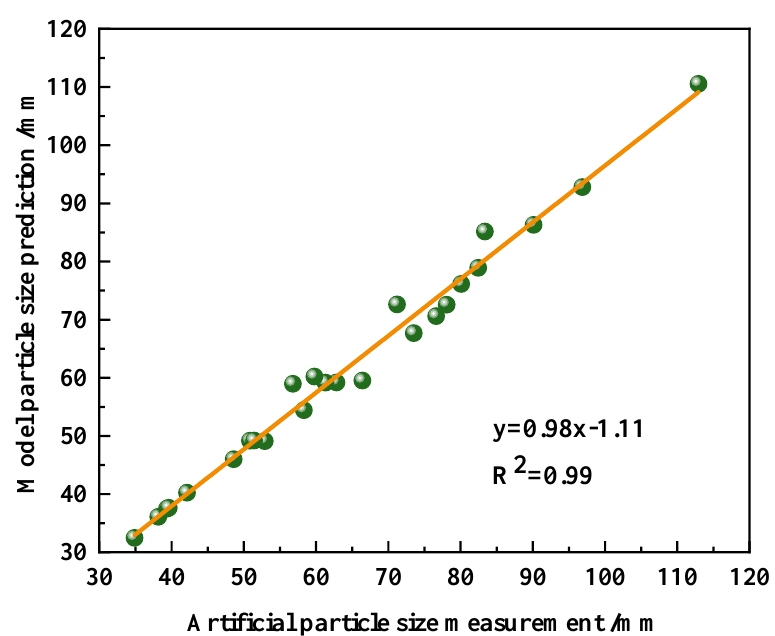
Figure 7. Recognition result.